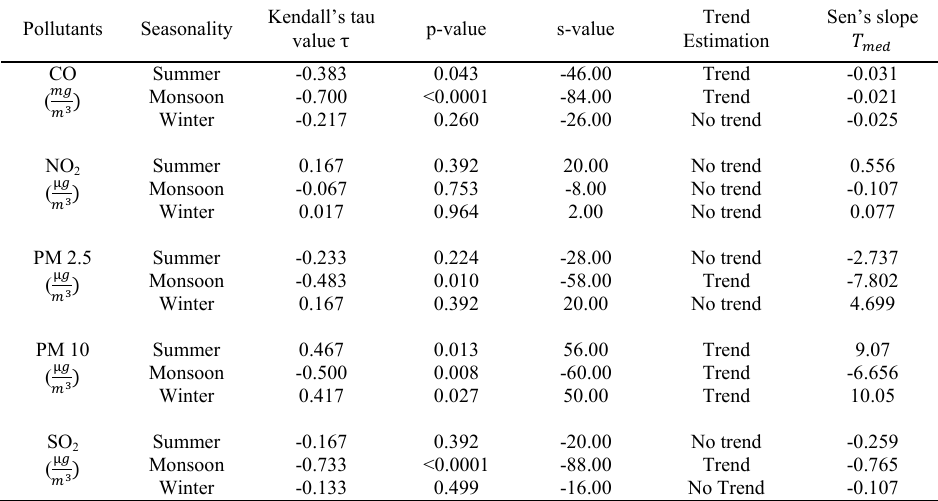
level, with a negative value of Kendall’s tau, so the null hypothesis is rejected confirming the alternate hypothesis of acceptance of trend in the time-series data. Similarly, for monsoon also, tau value of CO is -0.700 (negative) and the p-value is 0.00018 which is below 0.05 ensuring the existence of a negative Table 1: Results of M-K and Sen’s slope estimator test on different pollutants data of Varanasi over a seasonal scale from the year 2013 to 2016